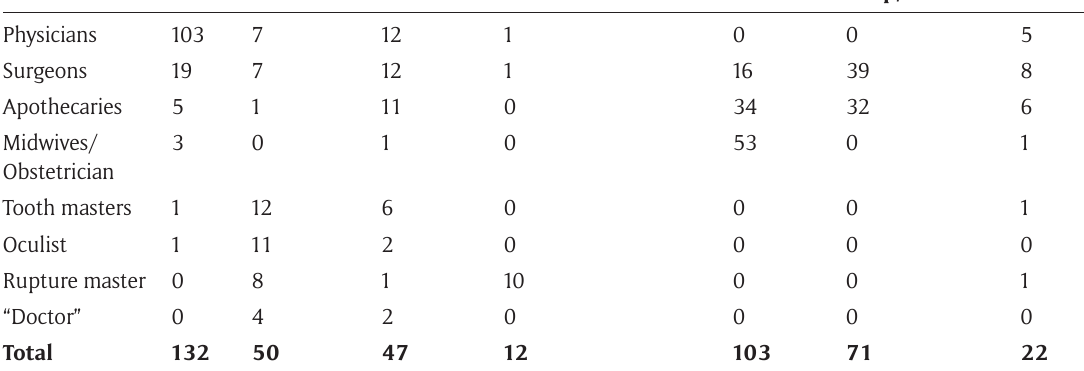
Table 2: Advertisements with medical products and activities, divided by profession Books Treatments Medicines Medical instruments Vacancies Shop/business